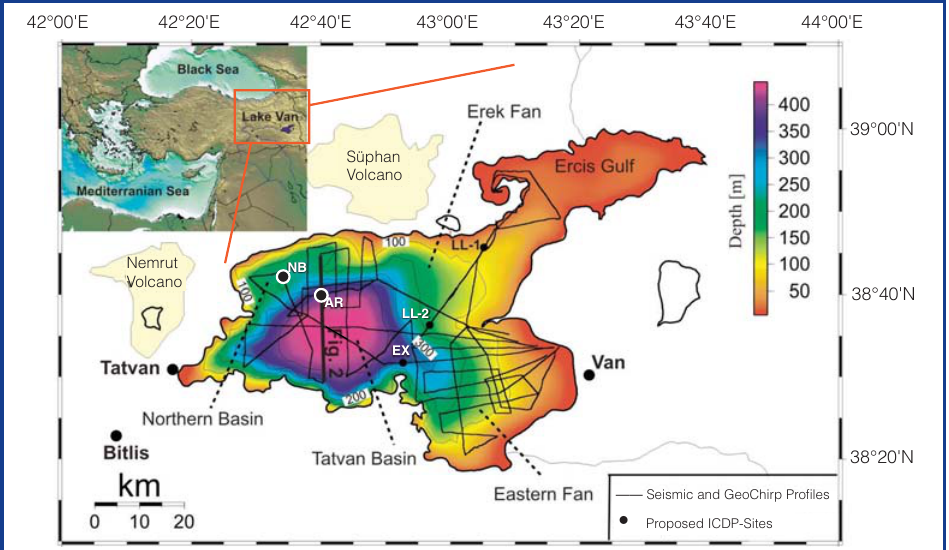
Figure 1. Bathymetric map of Lake Van with location of available seismic profiles and originally proposed drill sites. Ahlat Ridge (AR) and Northern Basin (NB) were finally